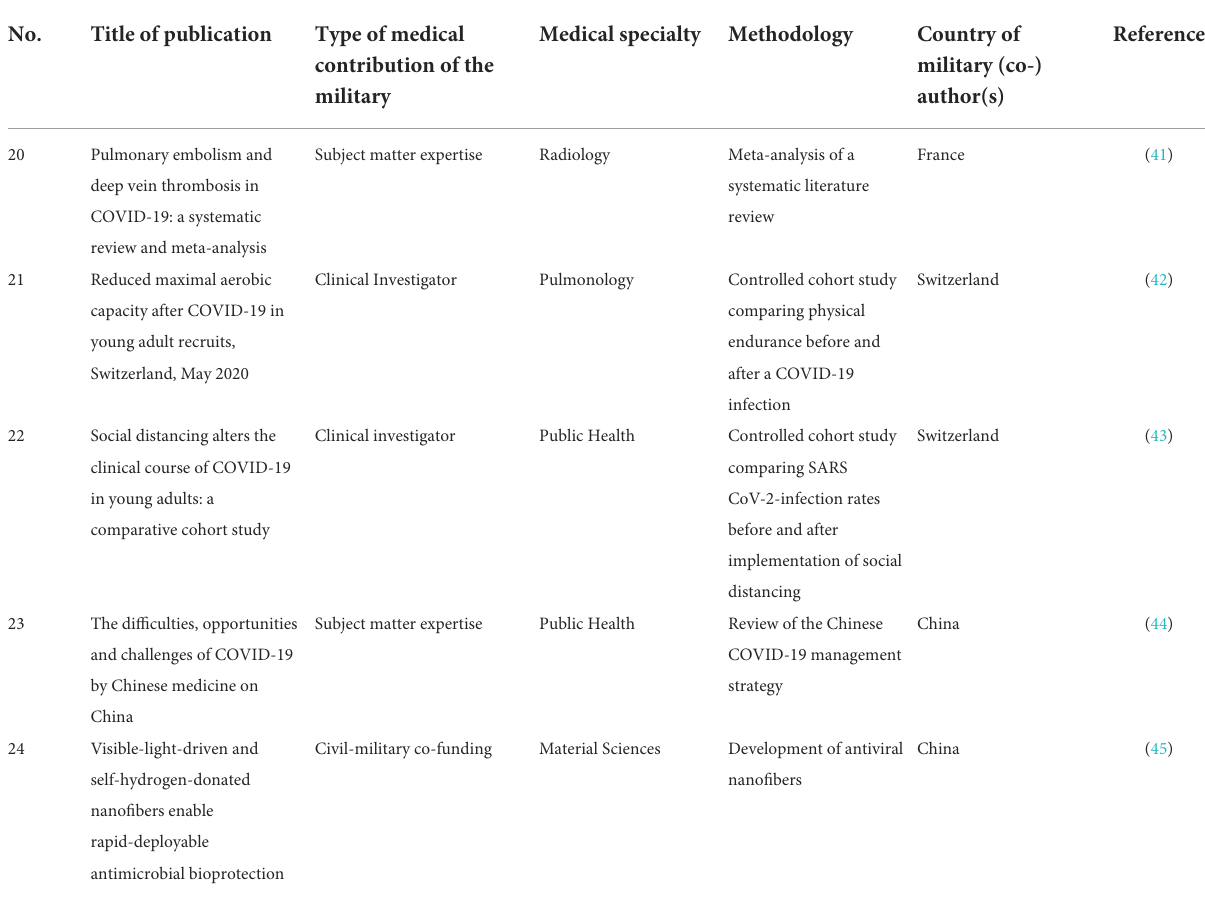
FIGURE3 Countries of military (co-) authors’ affiliation in medico-scientific civil-military publications during the COVID-19 pandemic (in red).